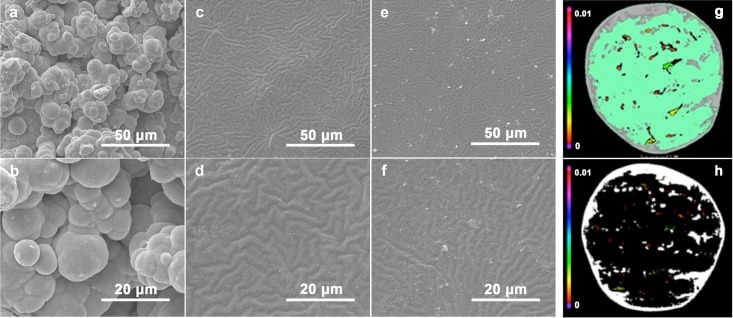
SEM images surface morphology of (a, b) MCM, (c, d) PCM and (e, f) CCM group. (b), (d) and (f) are the larger image of (a), (c) and (e), respectively. (g)&(h) Porosity distribution in the typical slice of PCM. C/C composite stands out in green, PDMS stands out in gray, porosities stands our in multicolor. Unit: mm2.